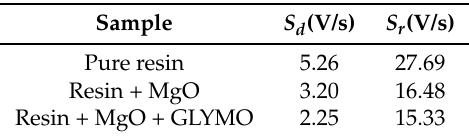
Table 4. Results of voltage response